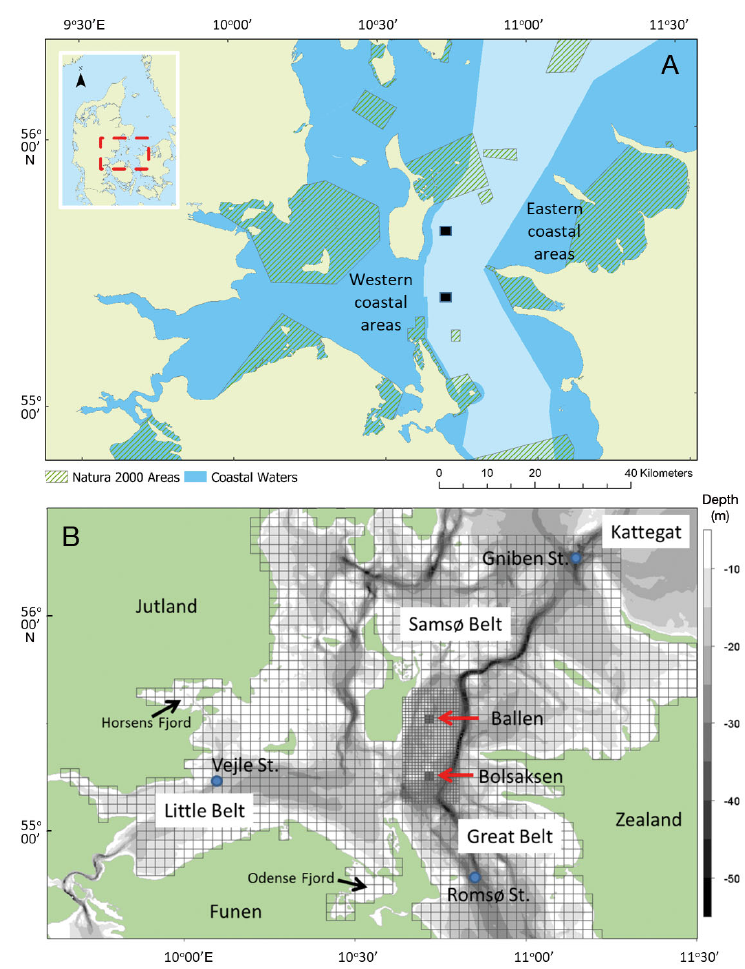
Fig. 1. Area around Samsø Belt in Denmark. (A) Eastern and western coastal water areas (blue) administrated according to the Water Framework Direc- tive, Natura 2000 sites (hatched lines), and potential locations of 2 fish farms (Ballen and Bolsaksen, black squares) located in open waters (light blue). (B) Model mesh, bathymetry and the monitoring stations (blue